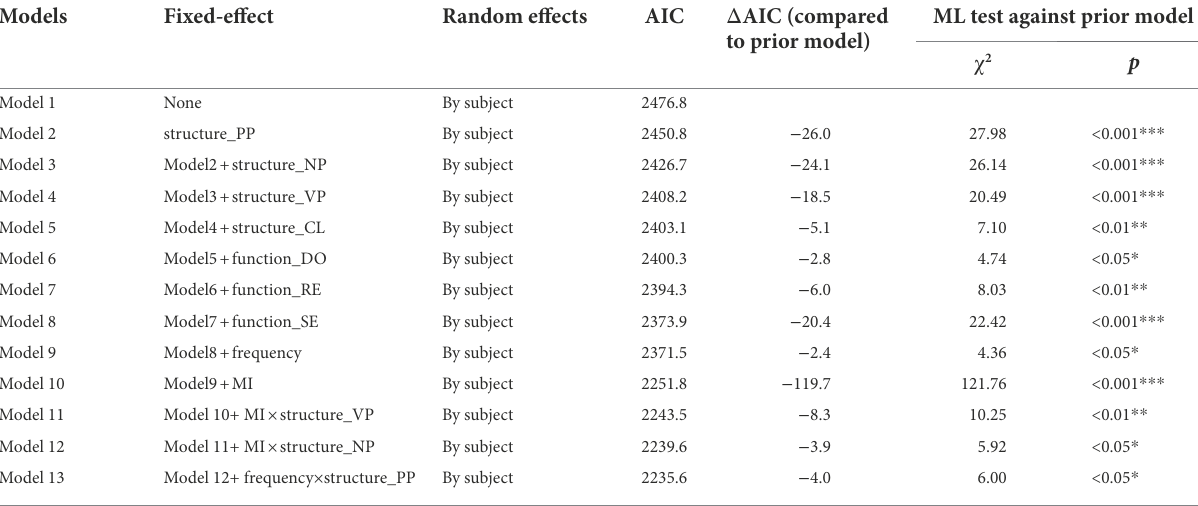
TABLE 1 Comparing the best fit model (model 13) to less complex models.